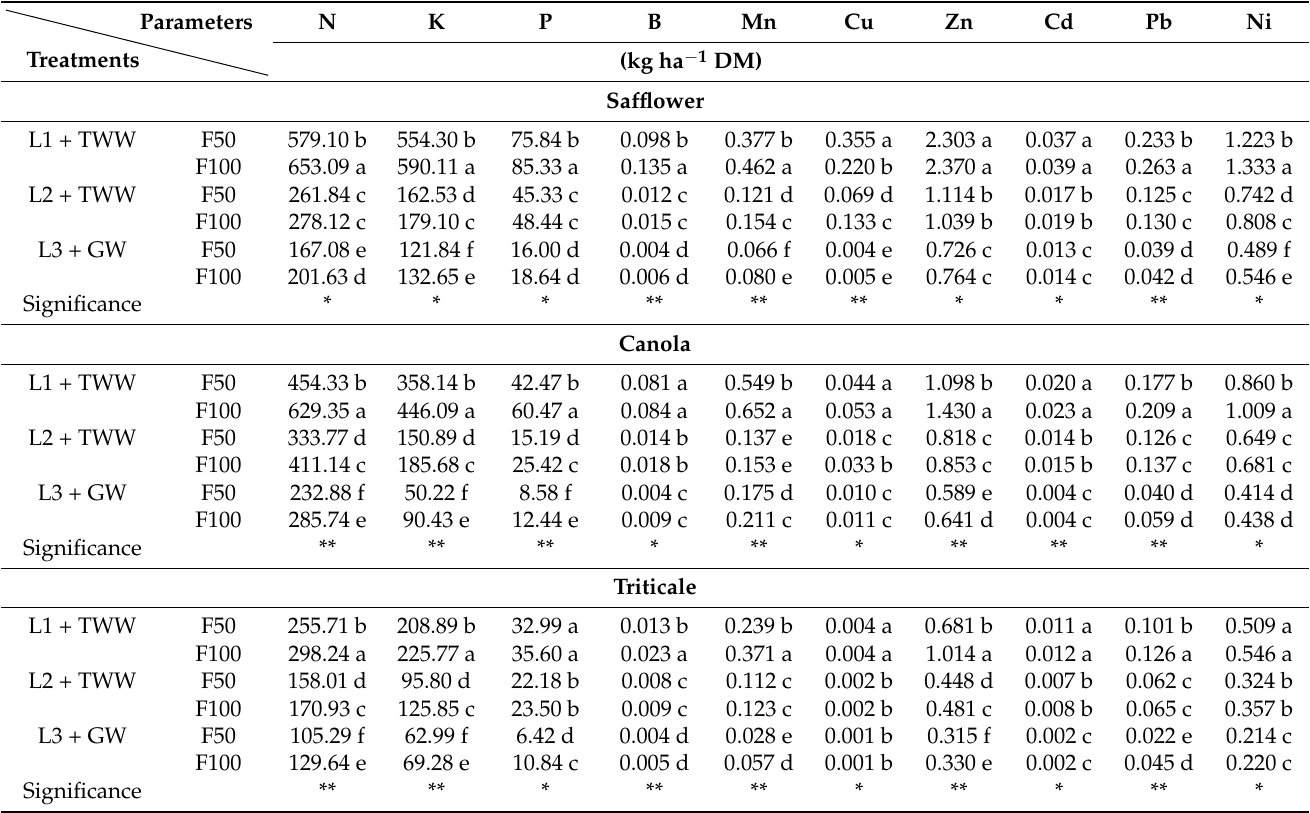
Table 7. Interaction effects of water resources and fertilization treatments on macro-, trace-elements, and heavy metals uptake (kg ha − 1 ) of safflower, canola, and